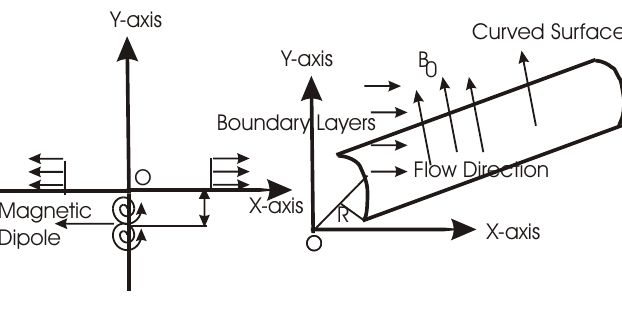
Figure 1. Schematic diagram of the